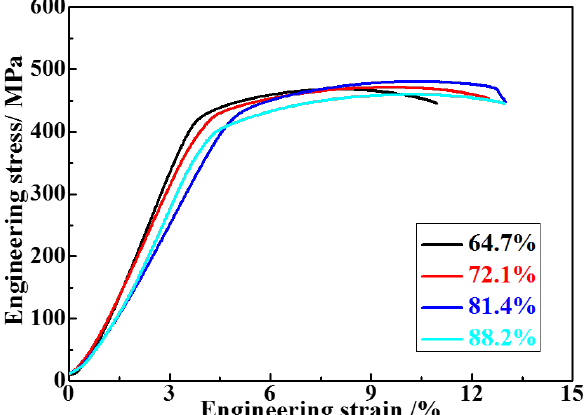
Figure 6. Tensile properties of the T6 treated samples with various rolling reductions.